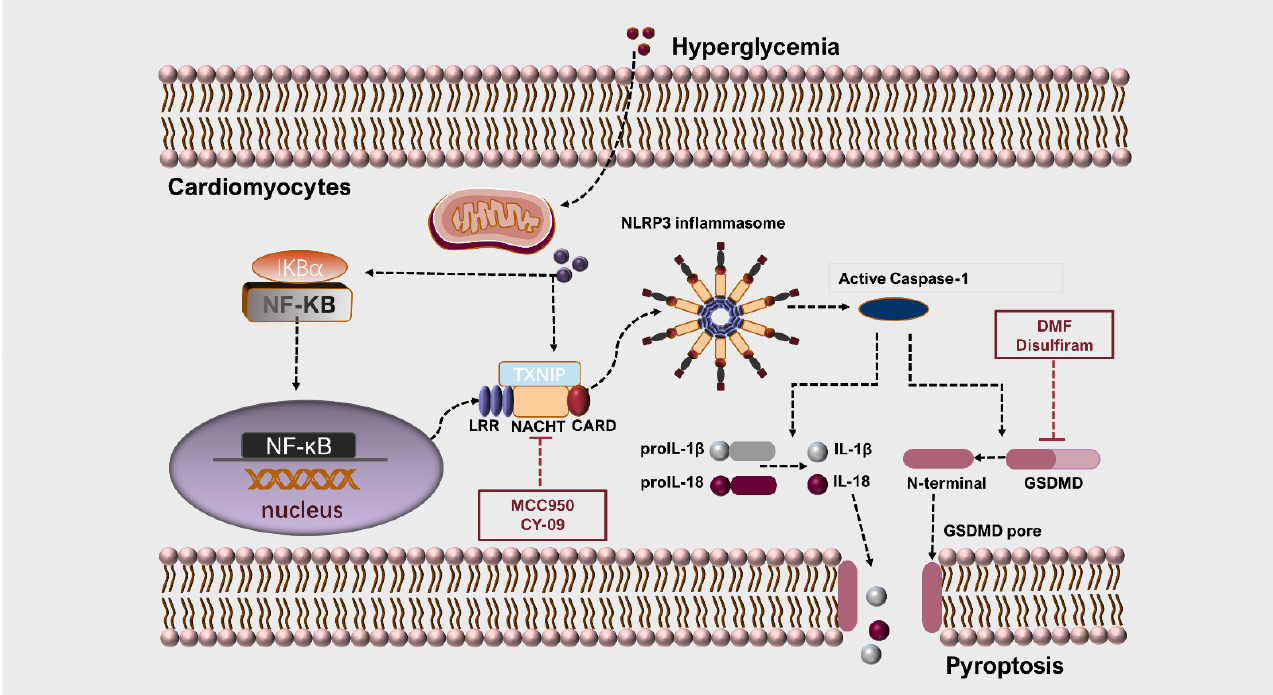
Figure 3. Mechanisms of NLRP3 inflammasome and pyroptosis in DCM. Taking cardiomyocytes as an example, hyperglycemia increases the generation of intracellular ROS, induced by mitochondrial dysfunction, which causes the separation of TXNIP from TRX and binds to NLRP3. This process results in NLRP3 inflammasome activation and pro ‐ caspase ‐ 1 autocleavage. Additionally, ROS activates NF ‐κ B, promoting the construction of molecular platform for NLRP3 inflammasome and self ‐ cleavage of caspase ‐ 1, then facilitates the procession of IL ‐ 1 β and IL ‐ 18. Activated caspase ‐ 1 also promotes GSDMD cleavage into its active form, subsequently inducing membrane pore formation and leading to cellular swelling and pyroptosis. CY ‐ 09 and MCC950 are the special inhibitors of NLRP3, which can exert an inhibitory effect by combining directly into ATP ‐ binding motif of NACHT domain and restraining the ATPase activity of NLRP3. DMF can respond to GSDMD at a pivotal cysteine residue to promote GSDMD succination, then affects the interaction between GSDMD and caspases and consequent reactions. Disulfiram, a potent inhibitor of GSDMD, can abolish the formation of plasma membranes pore induced by GSDMD.